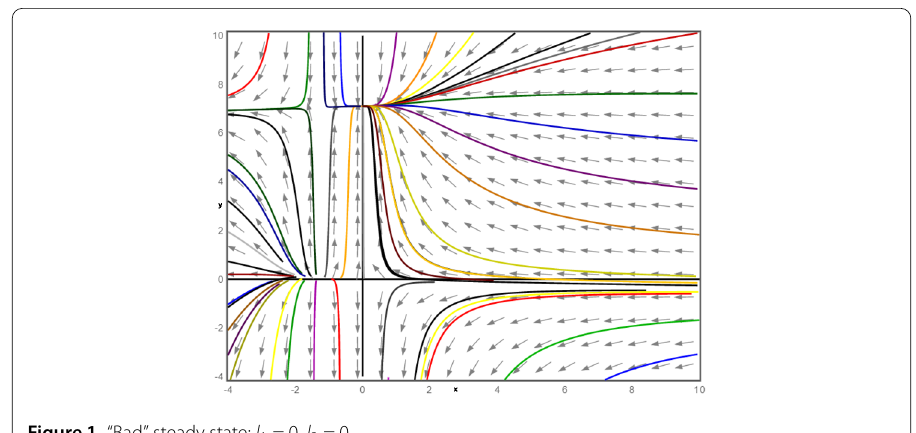
Figure 1 “Bad” steady state: l 1 = 0, l 2 = 0